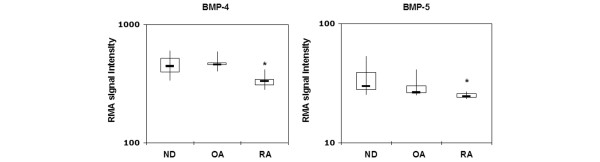
Expression of BMP-4 and BMP-5 in synovial tissues detected by microarray technique. Results are presented on a logarithmic scale with maximum, minimum, quartiles and median. Where indicated with an asterisk, there were significant differences from normal tissues (p < 0.05; t test). Rheumatoid arthritis (RA) versus normal donors (ND): bone morphogenetic protein (BMP)-4, p = 0.0009 (adjusted p ≤ 0.0083); BMP-5, p = 0.0142 (probe set ID 205431_s_at; data not shown) and p = 0.006 (probe set ID 205430_at) (adjusted p ≤ 0.009). Osteoarthritis (OA) versus ND: BMP-4, p = 0.854; BMP-5, p = 0.216 (probe set ID 205431_s_at) and p = 0.129 (probe set ID 205430_at) (no significance). RA versus OA: BMP-4, p = 0.000003 (adjusted p ≤ 0.0083); BMP-5, p = 0.2391 (probe set ID 205431_s_at) and p = 0.026 (probe set ID 205430_at) (no significance).